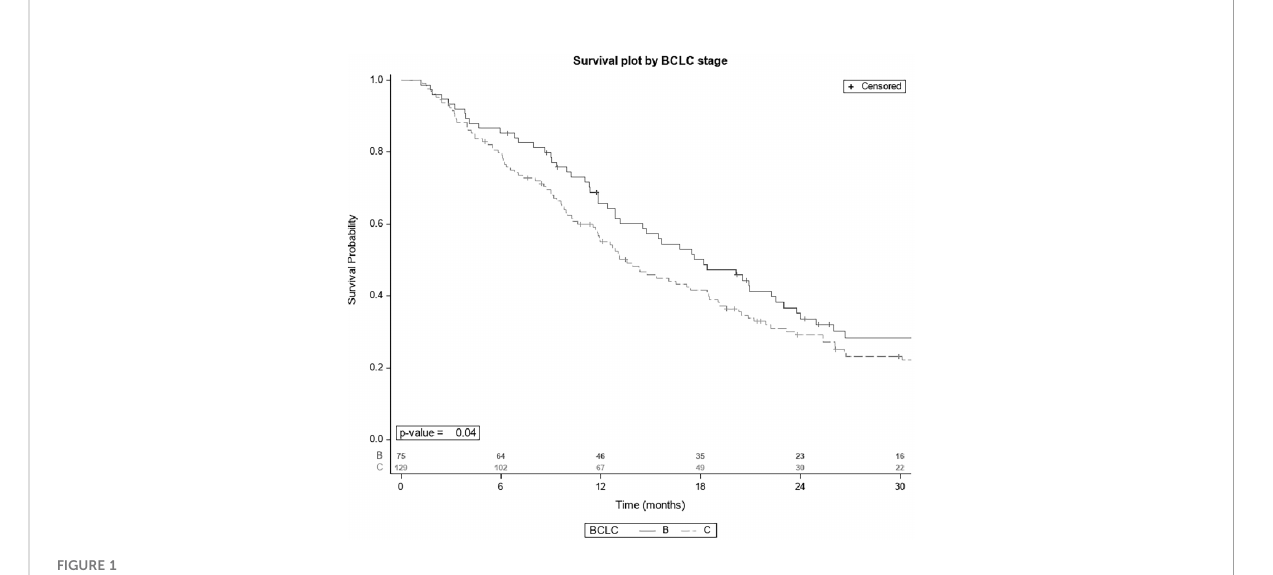
FIGURE 1 Survival plot by BCLC